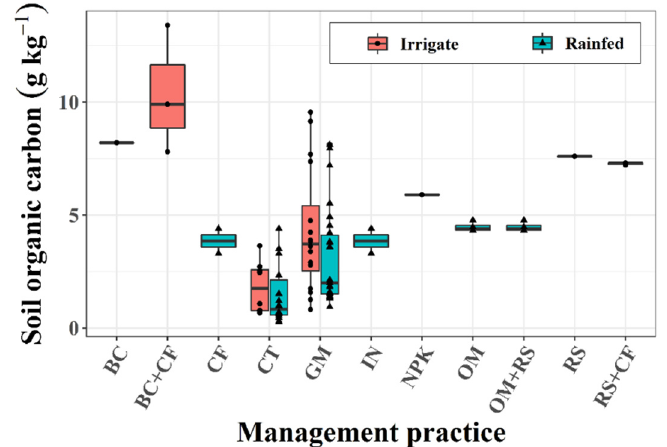
Figure 5. An overview of soil organic carbon in relation to management practice at the rice paddies of Northeast Thailand ( n = 89) (within the range of 0–40 cm depth) [41,49–70]. * BC = biochar, CF = chemical fertilizer, CT = control, GM = green manure, IN = intercropping, NPK = nitrogen, phosphorus, and potassium fertilizers, OM = organic material, RS = rice straw.